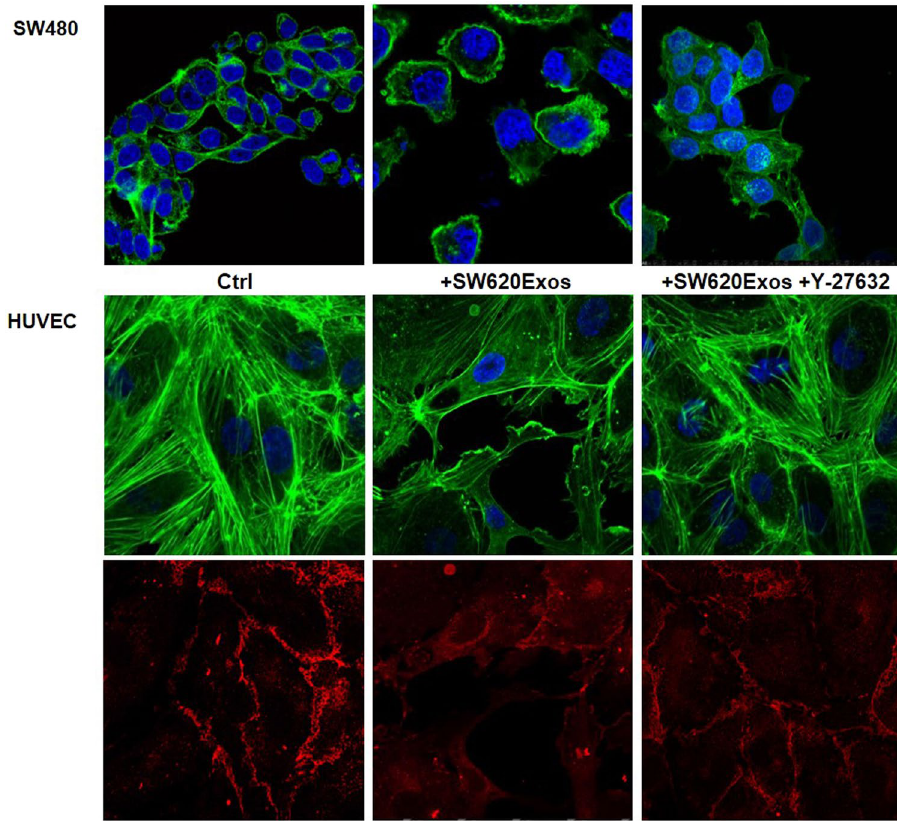
Figure 9. Inhibition of RhoA/Rock signaling in recipient cells reverts the effects induced by SW620Exos. Confocal micrographs show the ability of Y-27632 (10 mM) to revert morphological effects induced by SW620Exos (20 µ g/ml) in both SW480 cells and HUVECs. Cells were stained with Actin green (green) and nuclear counterstaining was performed using Hoescht (blue). HUVECs were also probed with anti-VE cadherin (red); Ctrl (Control): no treated